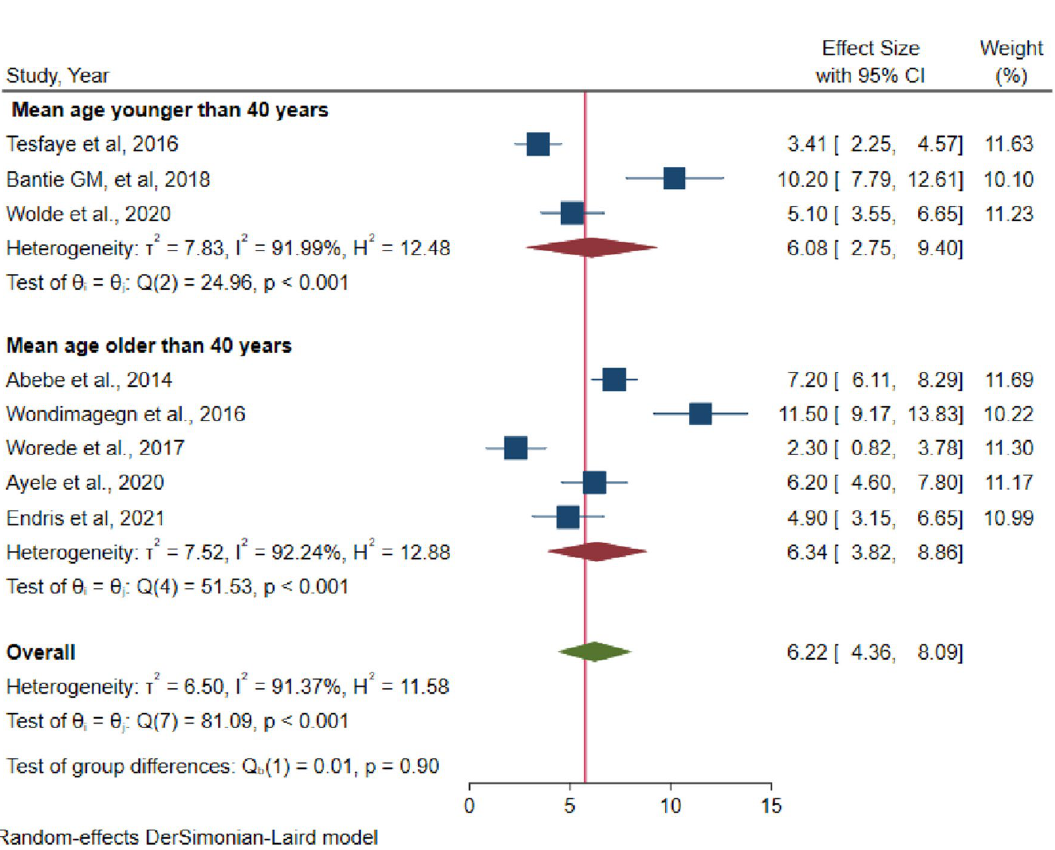
Figure 5. Subgroup analysis of the studies included in systematic review and meta-analysis on prevalence of undiagnosed DM in Ethiopia, 2021.